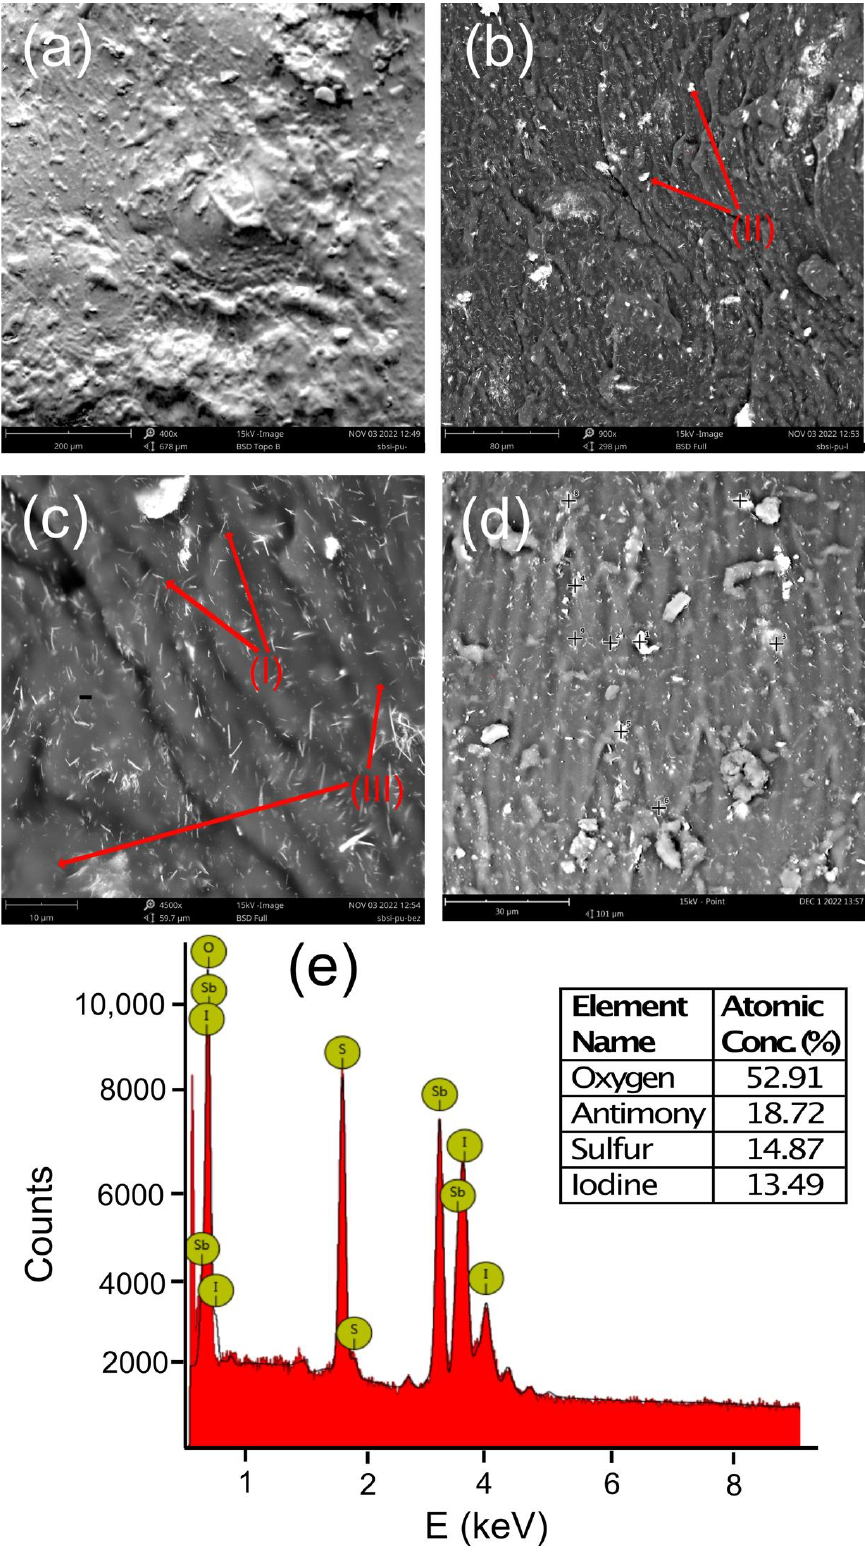
Figure 3. SEM images of ( a ) topology and ( b – d ) morphology of the SbSI/PU nanocomposite and ( e ) its EDS spectrum. The labels (I), (II), and (III) in Figures ( b , c ) indicate separate SbSI nanowires, agglomerations of SbSI nanowires, and the polyurethane matrix, respectively. The inset in Figure ( e ) presents the table with atomic concentrations of chemical elements detected in the